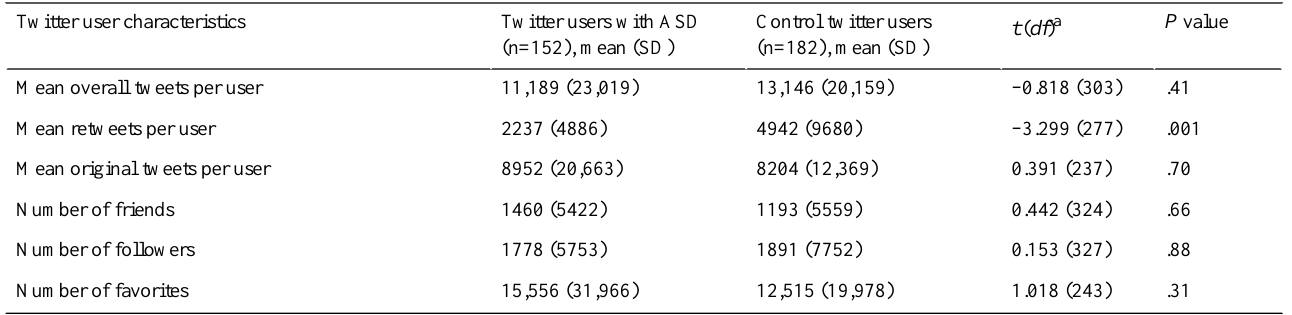
Table 3. The characteristics of Twitter users with autism spectrum disorder (ASD) and control users.